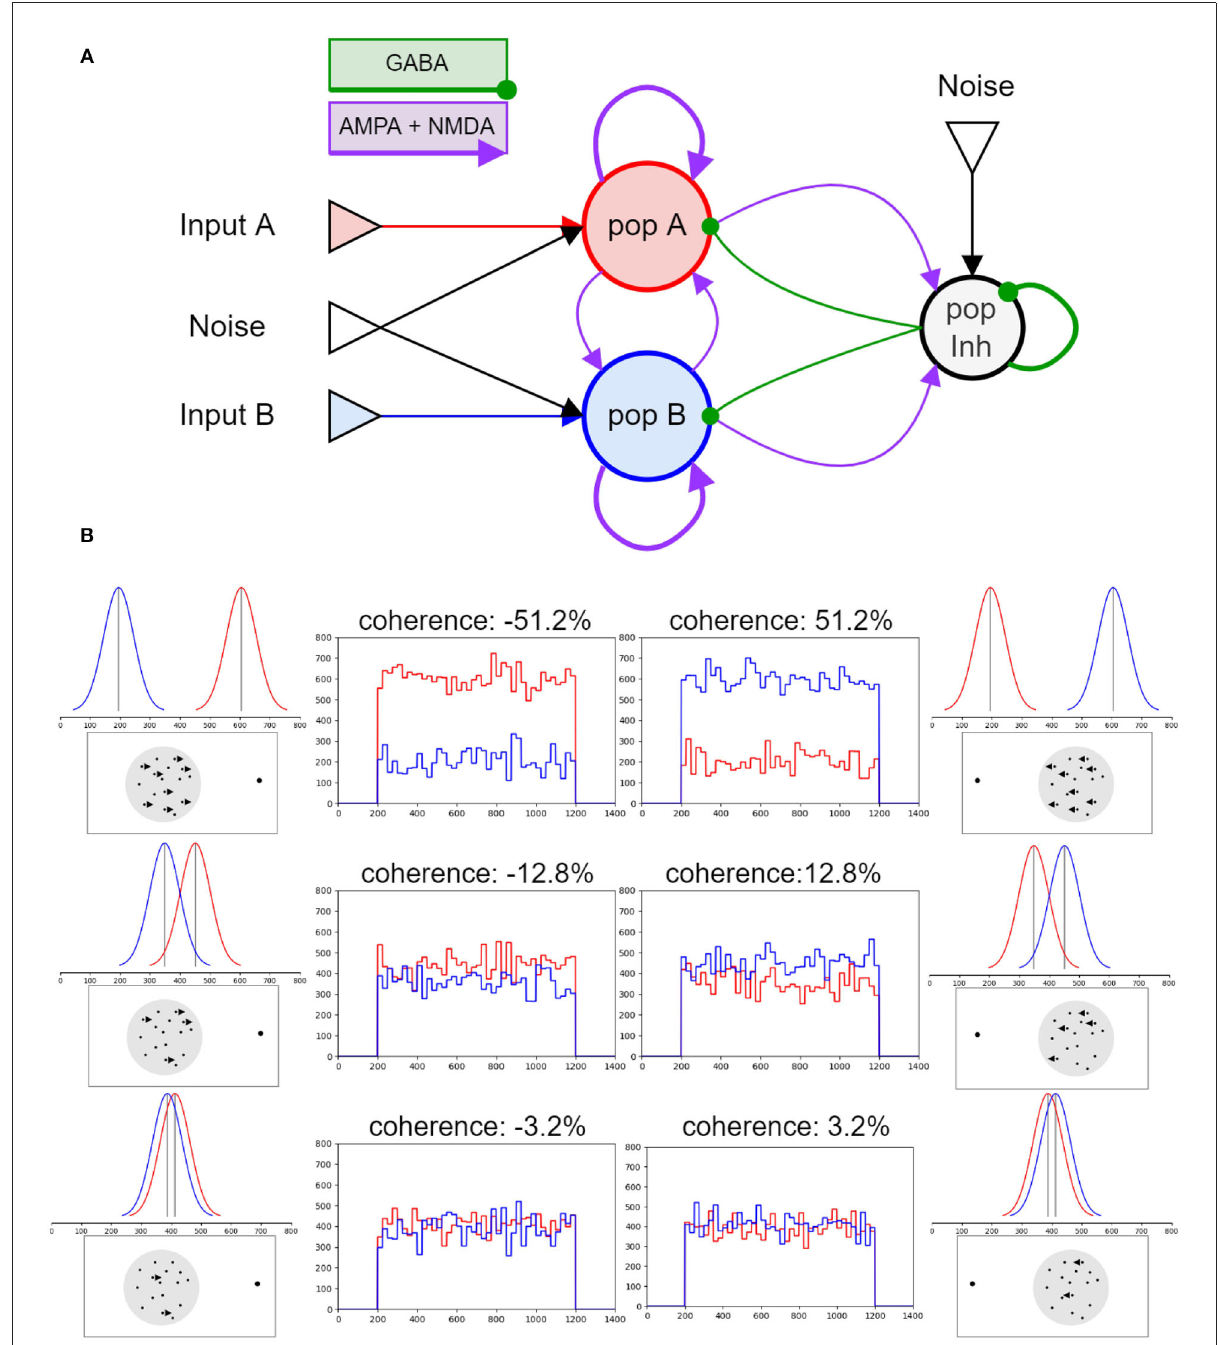
FIGURE1 Network architecture and stimulus model: (A) Schematic representation of the model proposed by Brunel et al. (2001). The two neural populations that contain excitatory pyramidal cells are represented in red, pop A responsive to stimulus A, and blue, pop B responsive to stimulus B. The gray circle represents the interneurons, i.e., the inhibitory population. All inputs, stimuli and noise, are Poisson generator represented by the triangles in the picture. A bigger circle represents numerous populations, while thicker connectors represent higher connection weights. (B) Stimulus model: here six levels of coherence are reported. How the inputs vary in time (central plots), the Gaussian distributions from which the values are sampled every 25 ms (upper lateral plots), and the correspondent representation of the physical visual stimulus (bottom lateral